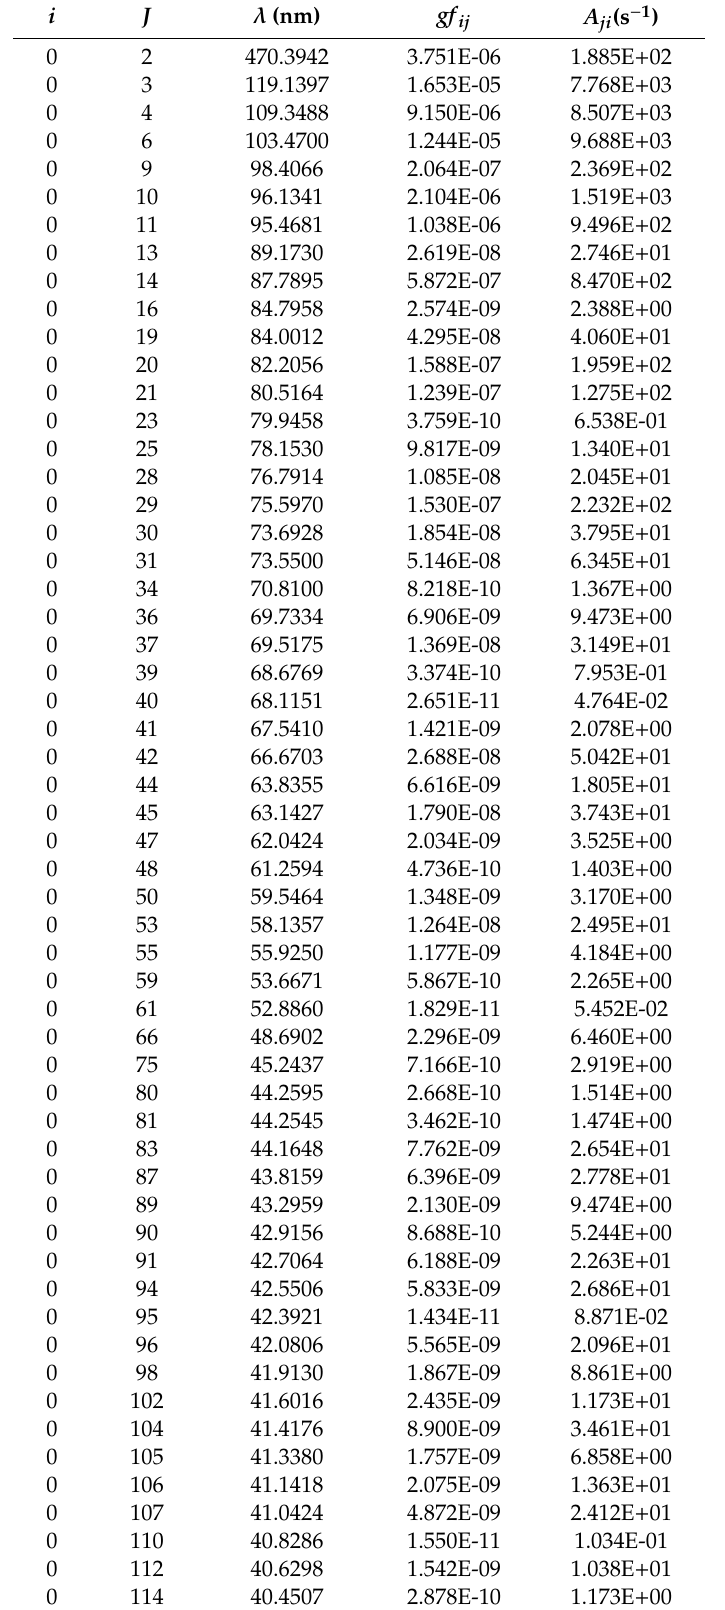
Table 4. Oscillator strengths gf ij , vacuum wavelengths λ (in nm), and transition probabilities A ji (in s − 1 ) for magnetic dipole (M1) transitions from the ground state calculated for Eu-like